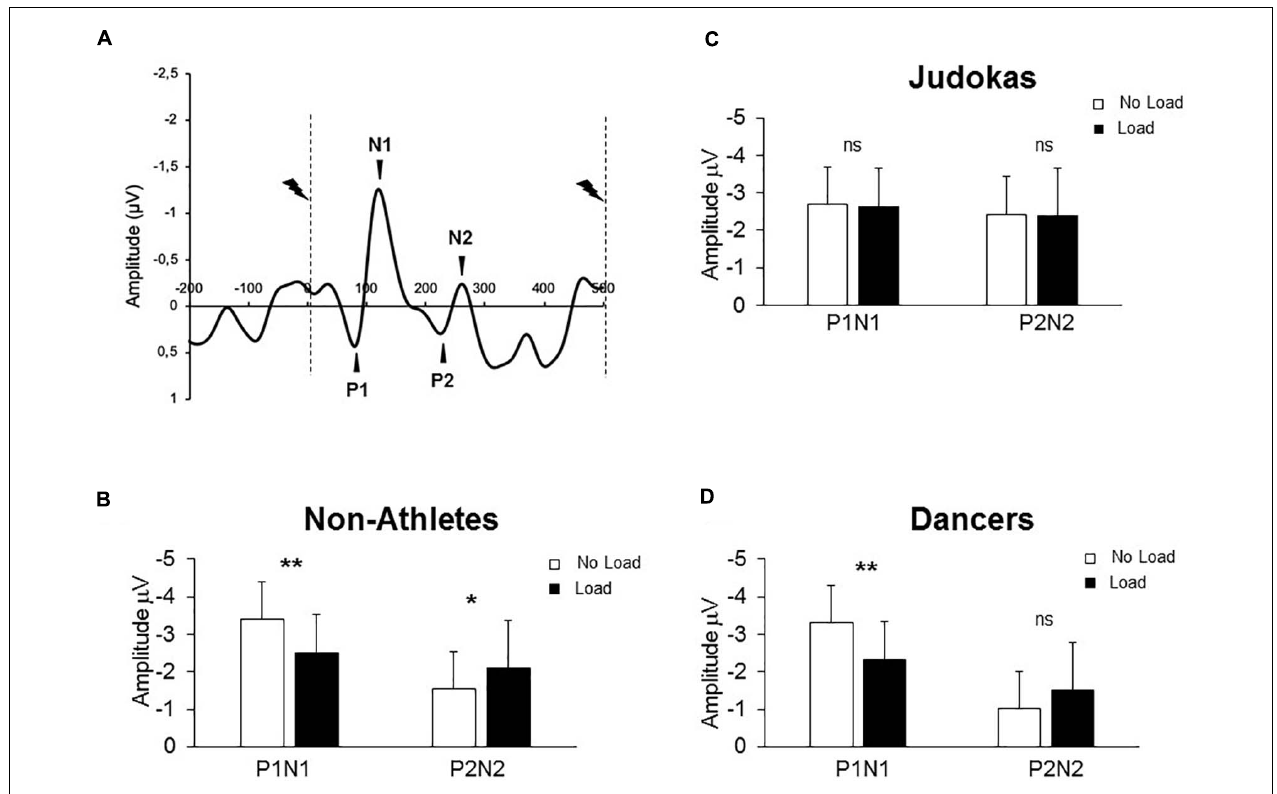
FIGURE 2 | (A) Grand average SEP for all Non-Athletes recorded at Cz in both conditions (Control and Loaded). Dashed lines indicate the moment of the stimulation. (B) ( Non-Athletes) (C) (Judokas) and (D) (Dancers): Mean for the 60 stimulations of the early and late SEPs amplitudes for each group (error bars are standard deviation across participants) (** p < 0.005; * p < 0.05 and ns: not